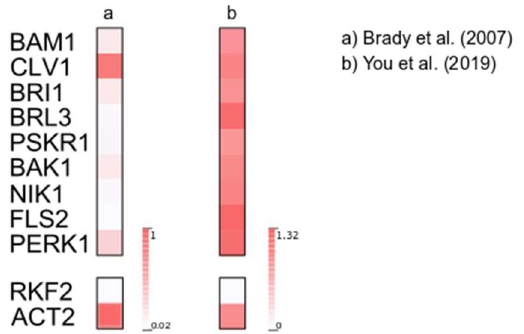
Figure 3. C4-interacting RLKs are expressed in phloem companion cells. Expression of selected RLKs according to publicly available transcriptome datasets [26,27]. For ( a ), mean expression values were selected from the SUC2:GFP-marked cell population dataset, in which companion cells are overrepresented [26]; for ( b ), mean expression values were selected from companion cells read counts in mock conditions [27]. All values are normalized to ACT2 expression in the same experiment. Expression of the pollen-specific RECEPTOR-LIKE SERINE / THREONINE KINASE 2 (RKF2) is shown as negative control.